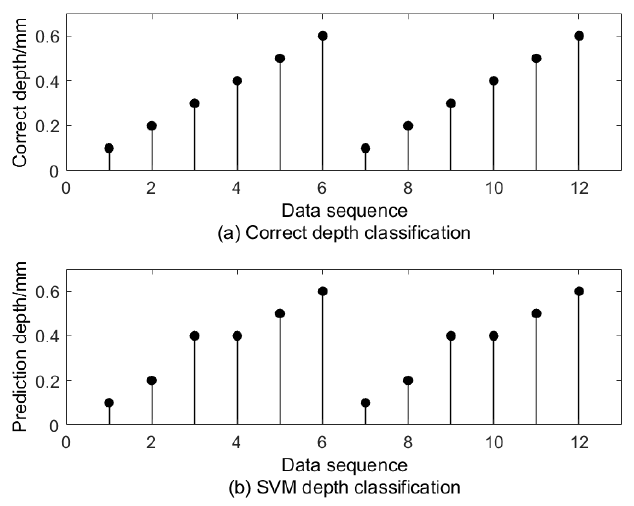
Figure 27. ( a ) Actual depth sequence; ( b ) prediction depth sequence.